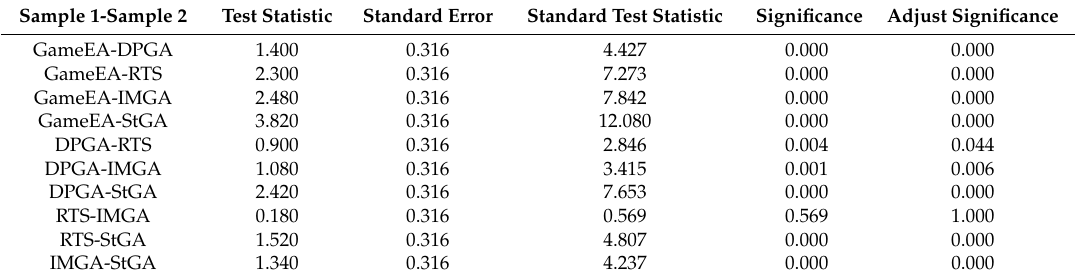
Table 5. Pairwise comparisons. Each row tests the null hypothesis that the Sample 1 and Sample 2 distributions are the same. Asymptotic significances (2-sided tests) are displayed. The significance level is